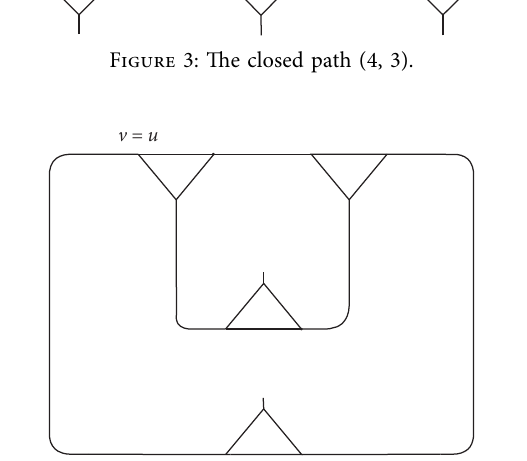
Figure 4: A homomorphic copy of ( 4 , 3 ) .